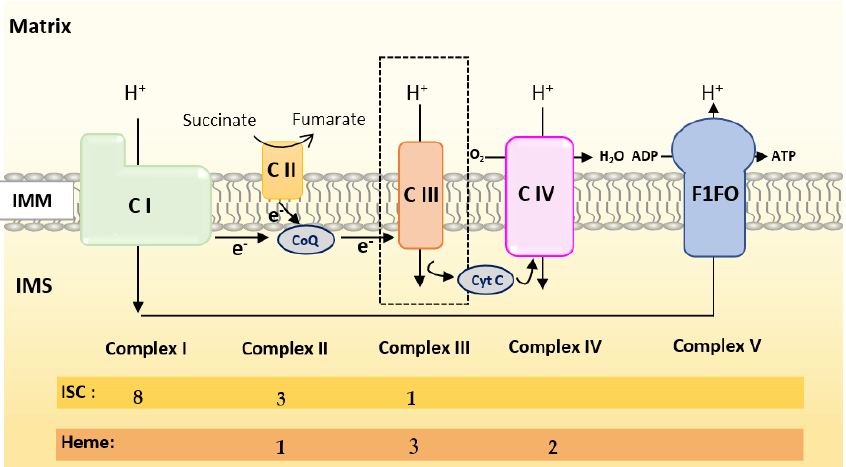
Figure 3. Scheme of the mitochondrial respiratory chain. For each complex, Iron Sulfur Cluster (ISC) and heme numbers are given. and heme numbers are